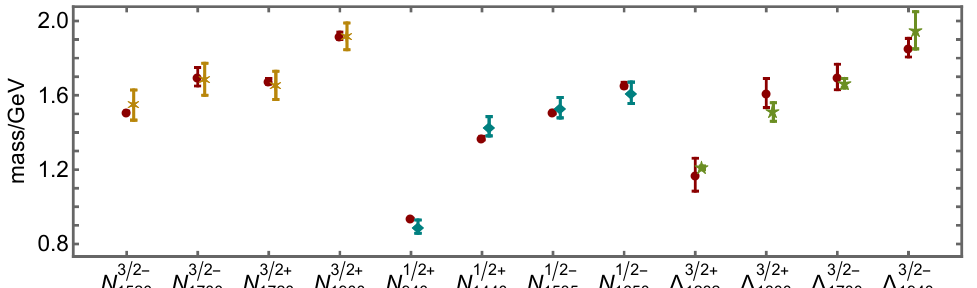
Figure 10. Real part of empirical pole position for each designated baryon [40] (red circle) compared with: calculated masses in Reference[268] (gold asterisks) after subtracting δ N 3/2 each; Reference[265] (teal diamonds) after subtracting δ N 1/2 five-pointed stars) after subtracting δ with an uncertainty that reflects a ± 5% change in diquark